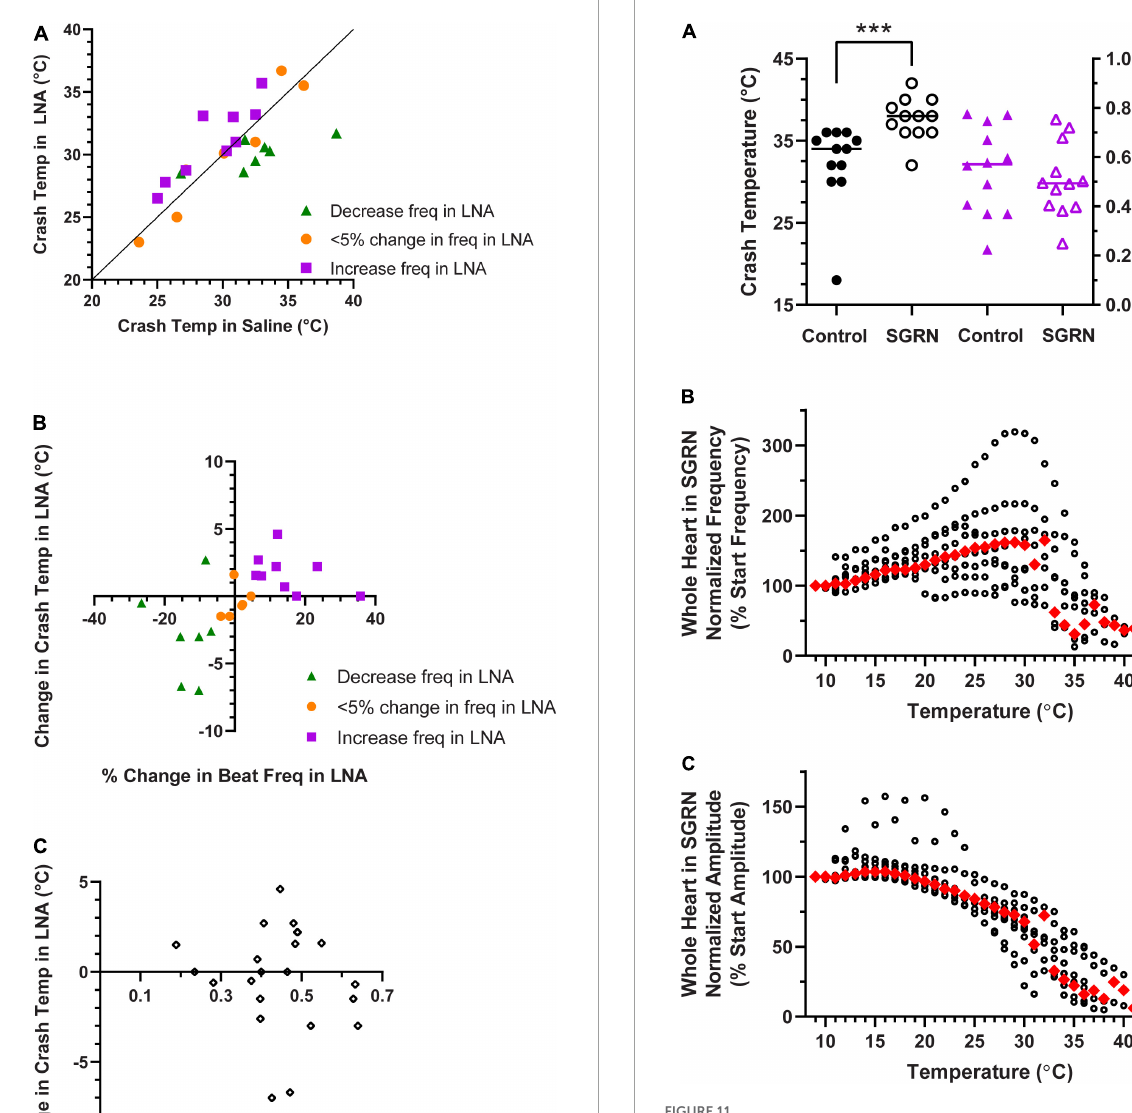
FIGURE11 Modulation of the cardiac neuromuscular system by SGRN increases crash temperature. (A) Comparison of crash temperatures between whole heart preparations perfused with saline (34 ◦ C, median) vs. 10 – 8 M SGRN (38 ◦ C, median) in the same hearts. SGRN extended the temperature tolerance of these hearts (Wilcoxon test; p = 0.0005, N = 12). However, although SGRN generally excites cardiac activity, at this concentration, contraction frequency increased in only about half of the hearts, while it decreased in the other half, so that the average change in contraction frequency was not altered by SGRN [right y-axis; saline: 0.57 Hz, SGRN: 0.49 Hz (median frequencies); Wilcoxon test; p = 0.47, N = 12]. (B) Normalized whole heart contraction frequency as a function of temperature during SGRN perfusion. Note that contraction frequency increased until about 29 ◦ C, which is when preparations began to crash. (C) Normalized whole heart contraction amplitude as a function of temperature during SGRN perfusion. Contraction amplitude with increased temperature until ∼ 19 ◦ C, at which point, it decreased until crash. Red triangles represent the median response at each temperature step for panels (B,C) . ***Indicates p <